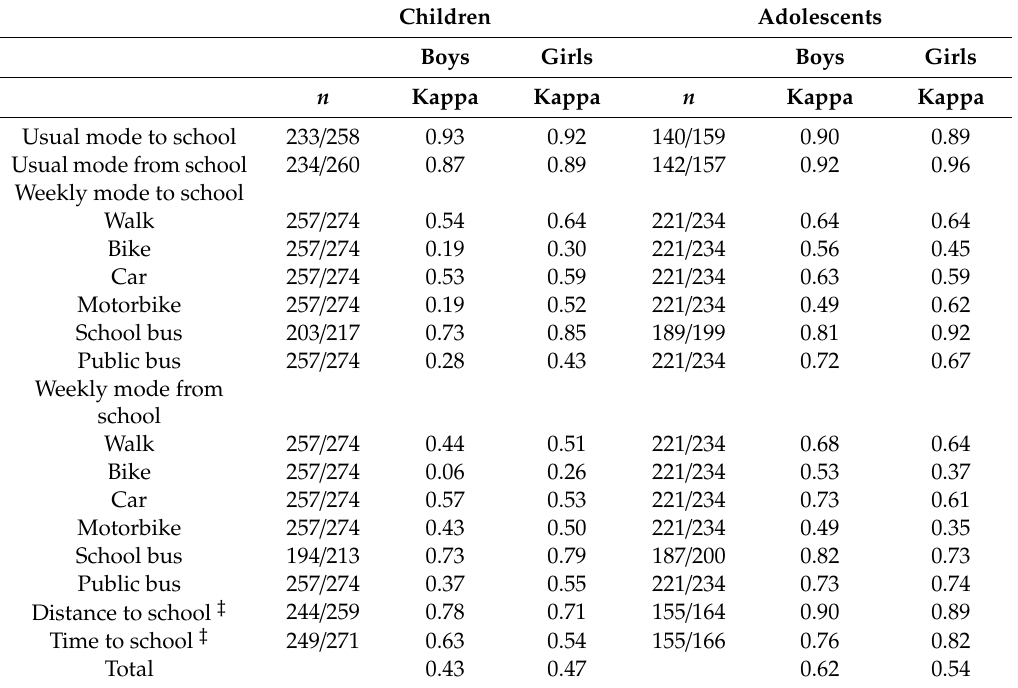
Table 5. Test-retest reliability of the “New Version of Mode and Frequency of Commuting To and From School” questionnaire in children and adolescents questionnaire by